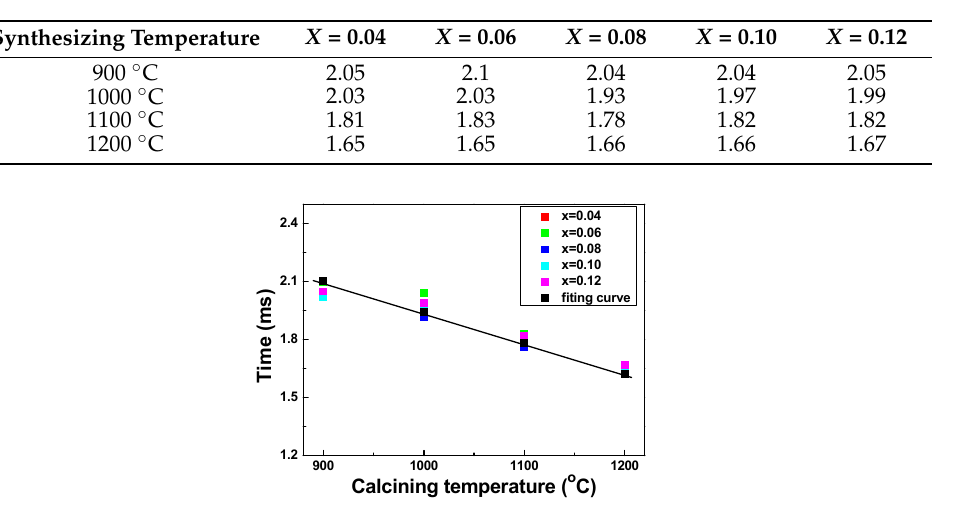
Figure 6. Fitting curve of lifetime for Sr 2 − x Eu x ZnMoO 6 phosphors as a function of the synthesizing temperature and concentration of Eu 3+ ions.